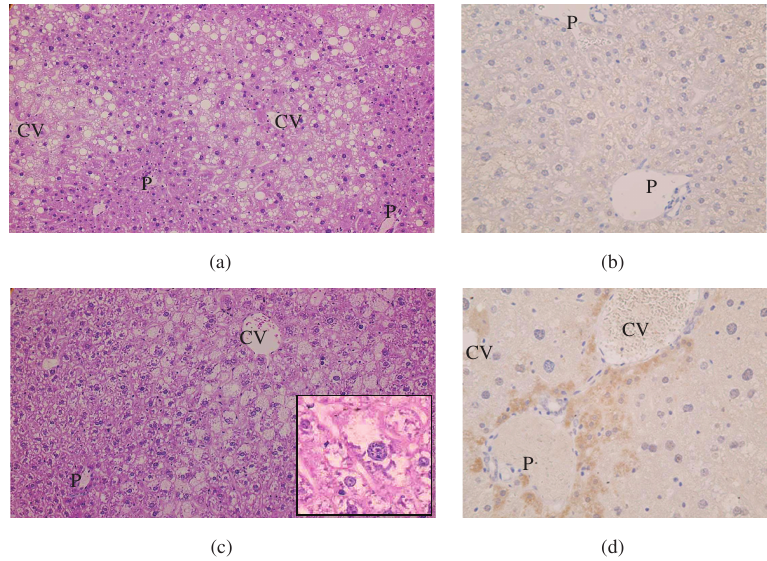
FIGURE 5: (a), (b) Liver of the control group. (a) H and E staining, × 200 magnification. In Zone3-Zone2, moderate fatty changes were observed. Ballooning degeneration was sporadically observed. (b) TNF- α immunostaining, × 400 magnification. No TNF- α expression was seen in hepatocytes or Kupffer cells. (P: portal tracts, CV: central vein) (c), (d) Liver of the HBOT group. (c) H and E staining, × 200 magnification. Fatty changes were less severe, while marked ballooning degeneration was observed. Mallory bodies were seen sporadically (inset). (d) TNF- α immunostaining, × 400 magnification. TNF- α expression was observed in the hepatocytes of the perivenular and periportal areas; however, it was not seen in Kupffer cells. (P: portal tracts, CV: central